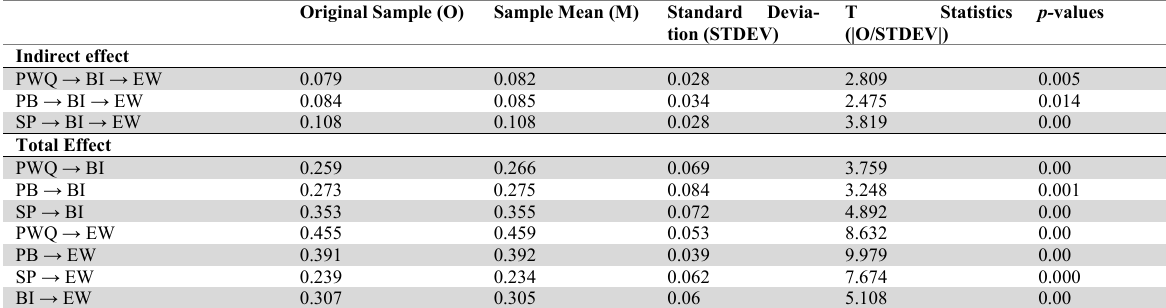
Indirect and Total